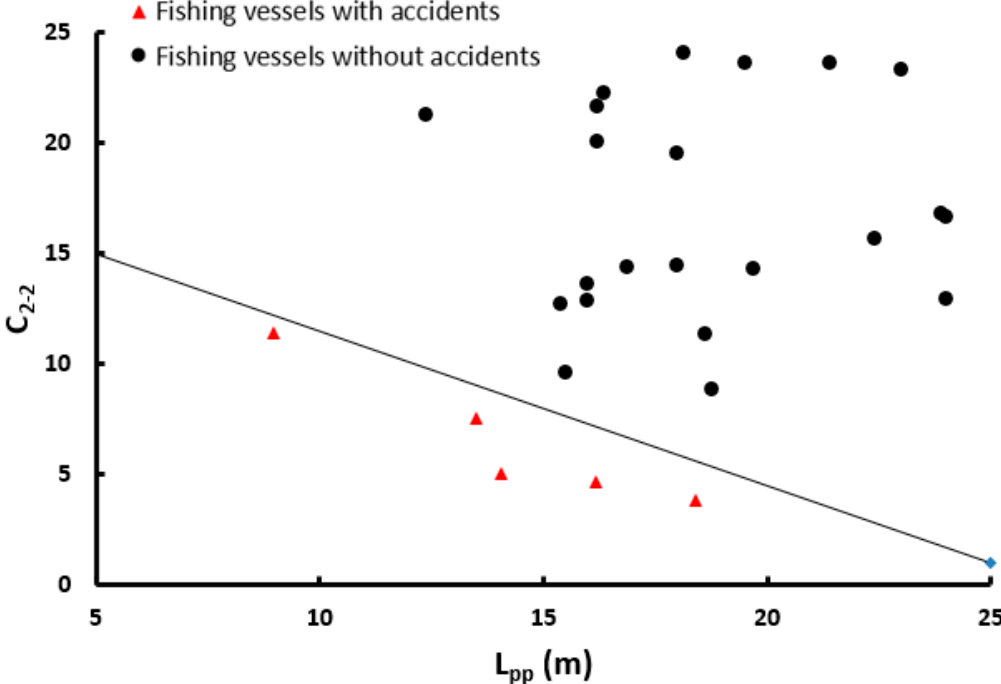
Figure 5. The effect of ship length ( L pp ) over C 2–2 coefficients for the analyzed vessels with and without accidents.